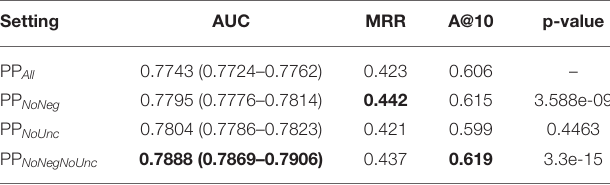
TABLE 3 | Results of classification of shared primary diagnosis, compared between different sets subsets of patient phenotype